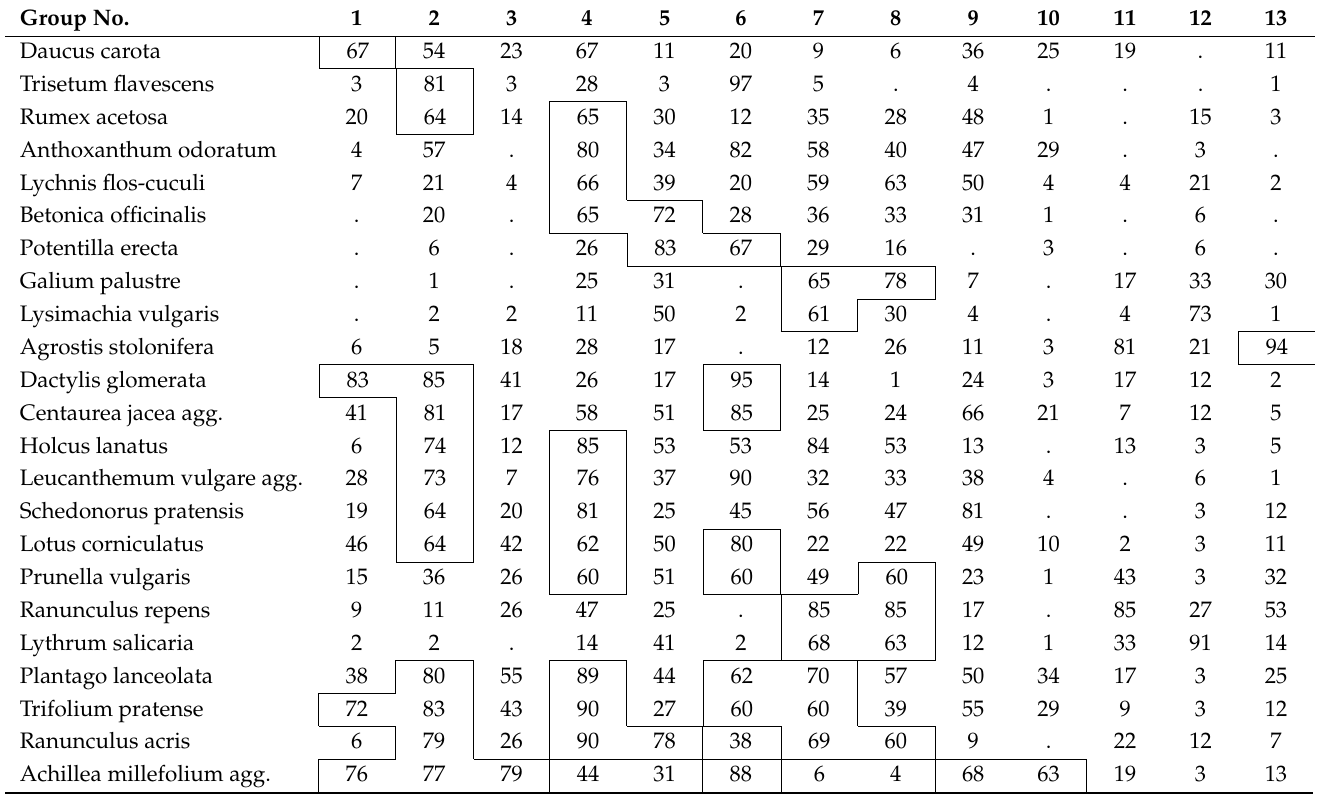
Achillea millefolium agg. Plots are arranged by meadow types: 1-semidry meadows ( Salvio nemorosae-Arrhenatherion ); 2-mesic meadows ( Arrhenatherion ); 3-mesic pastures ( Cynosurion ); 4-mesic to wet meadows in the western part of the area ( Alopecurion ); 5-wet oligotrophic meadows ( Molinion ); 6-montain mesic grasslands ( Triseto-Polygonion bistortae ); 7-wet eutrophic meadows ( Calthion ); 8-intermittent wet meadows ( Deschampsion ); 9-mesic to wet meadows in the eastern part of the area ( Trifolion pallidi ); 10-salt grasslands ( Trifolion-Ranunculion pedati ); 11-wet fringe pastures ( Mentho longifoliae-Junicion inflexi ); 12-wet fringe meadows ( Filipendulio-Petasition ); and 13-wet pastures ( Potentillon anserinae ). Only species that reach at least a constancy of 60% in an individual group are